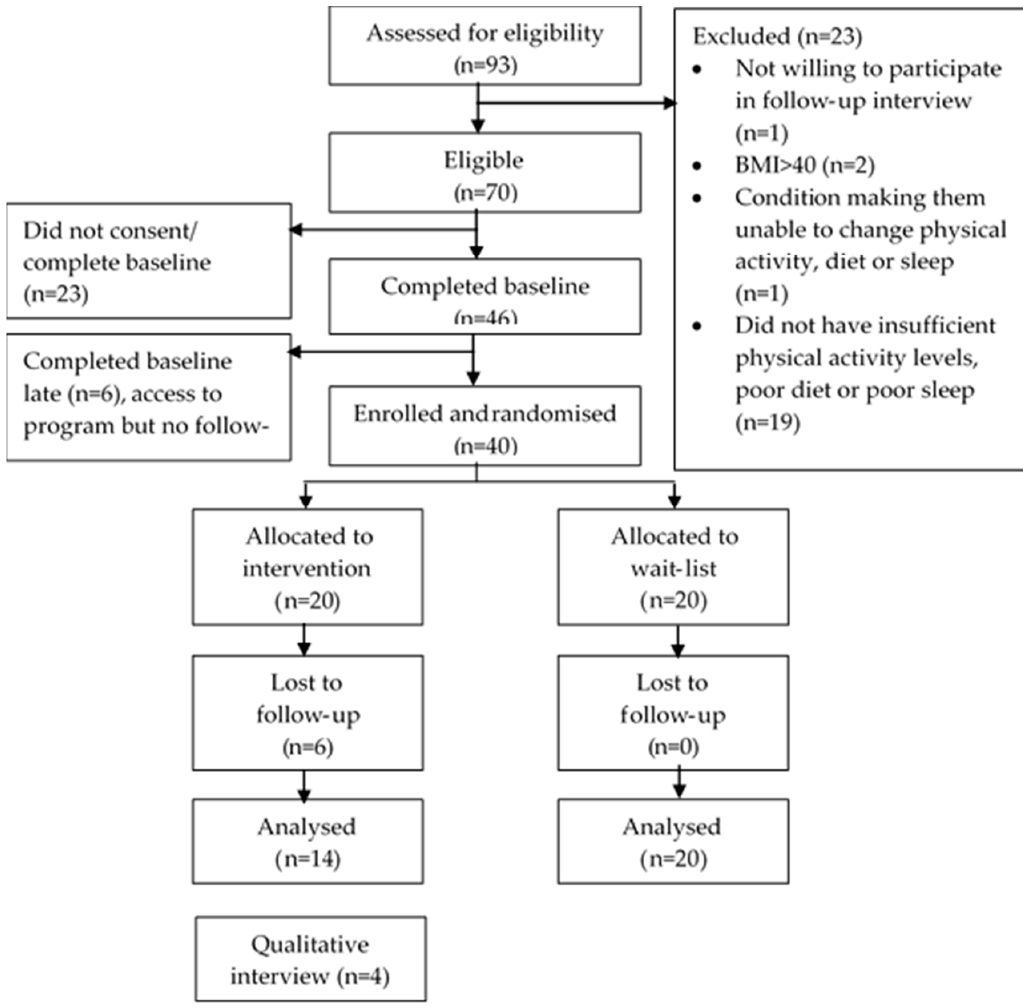
Figure 1. CONSORT flow chart describing the progress of participants through the trial. Flow of participants through the four-week shift-worker Move, Eat, and Sleep pilot